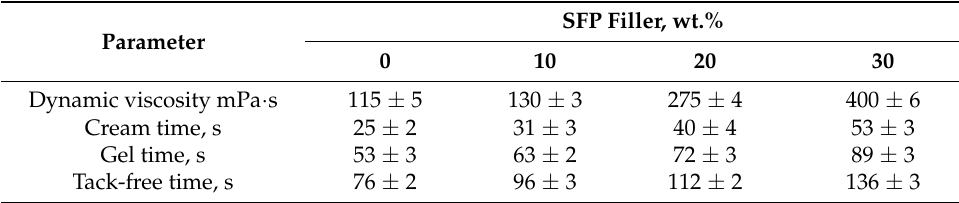
Table 2. Parameters of the foaming